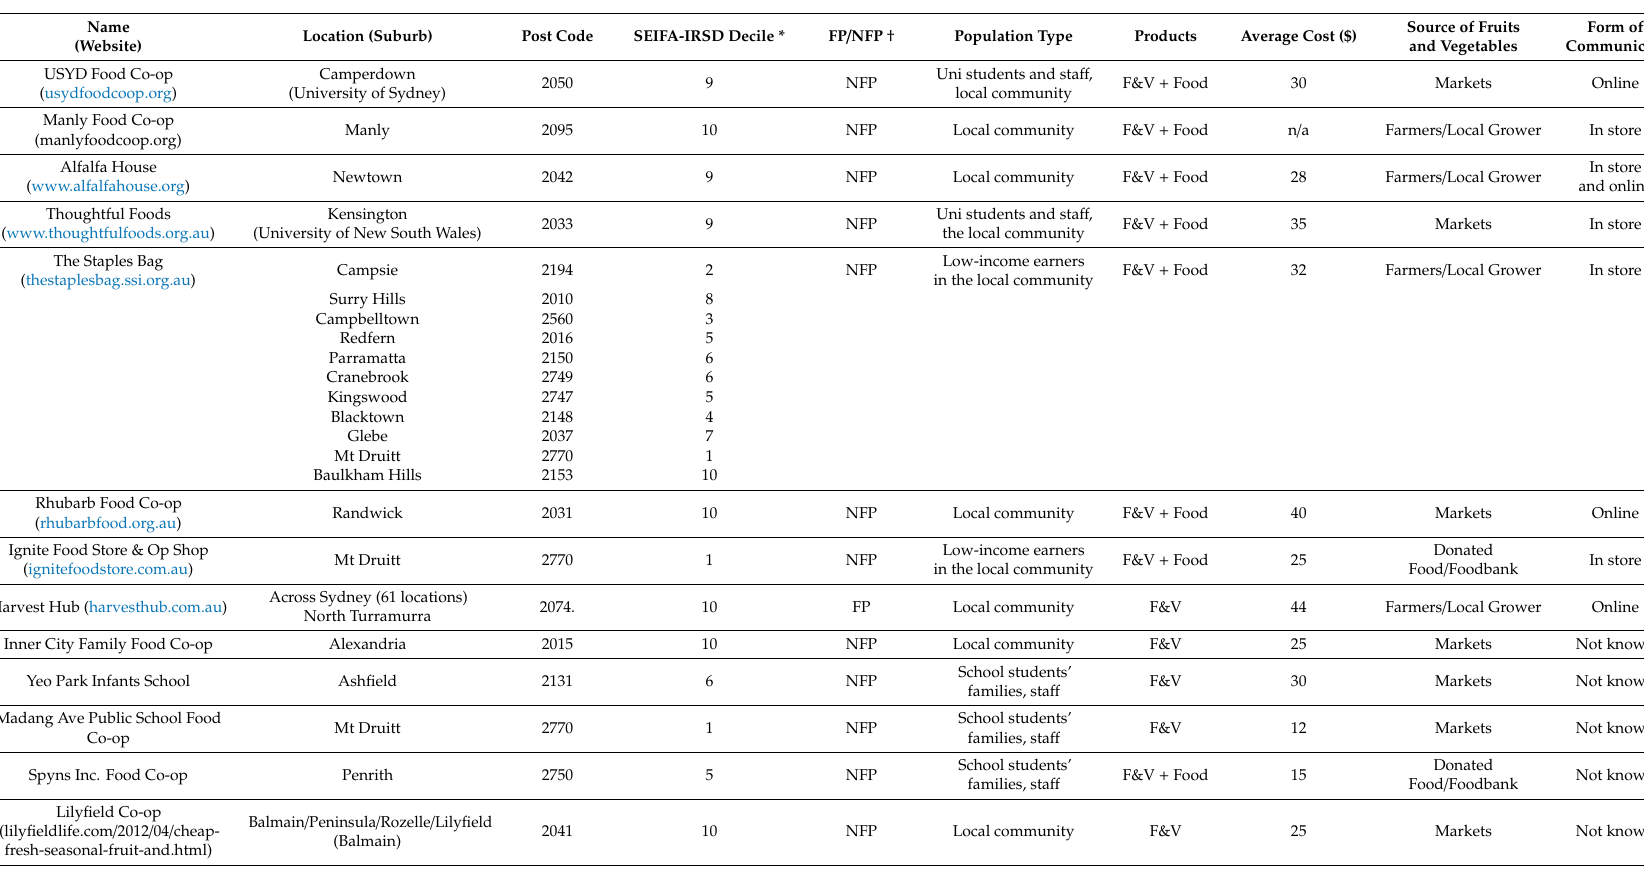
Table 1. Characteristics of the food co-ops identified in the Sydney Metropolitan